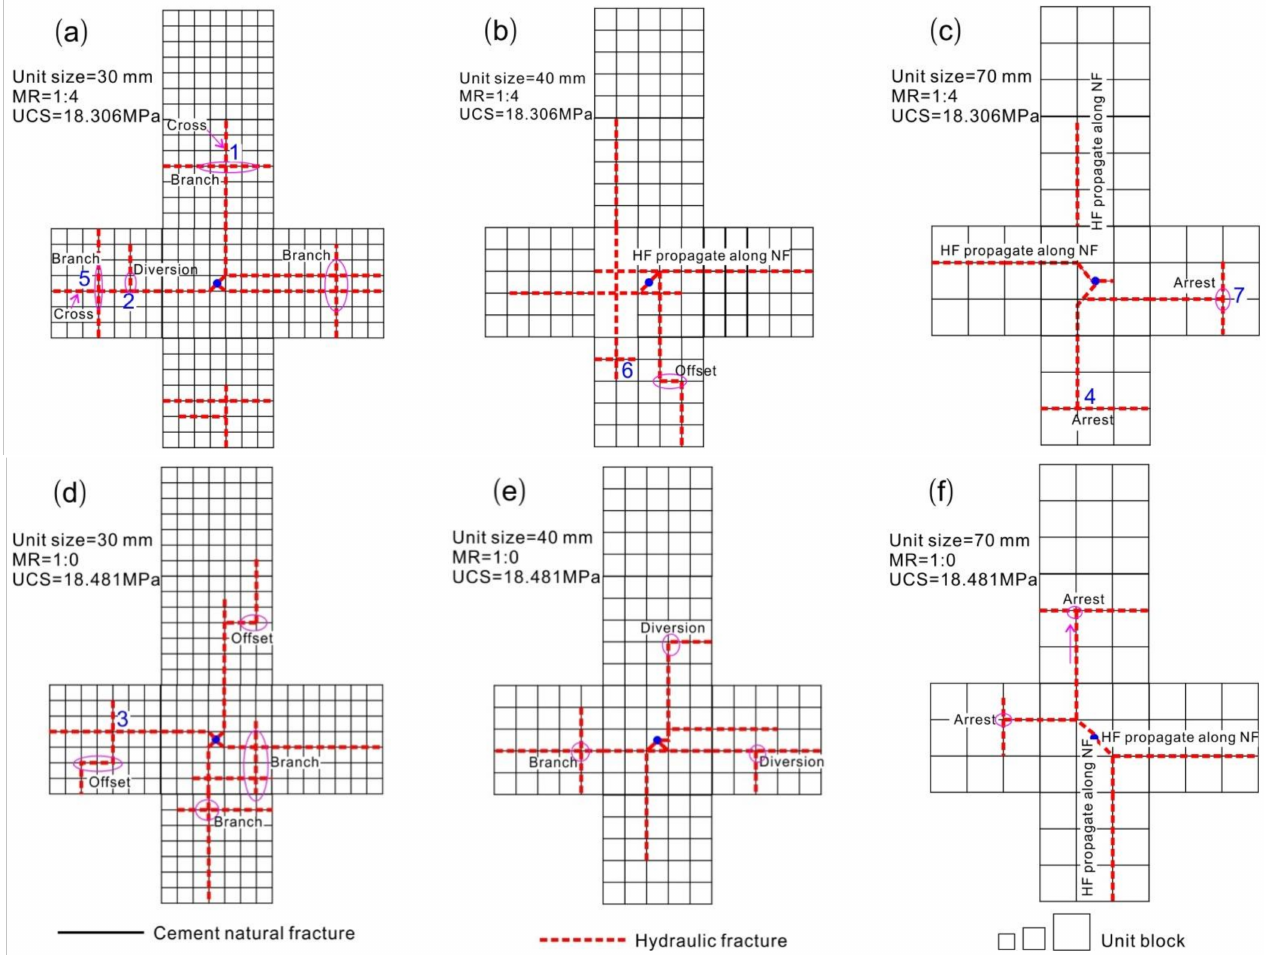
Figure 8. Sketch of the interaction between NFs and HFs. ( a – c ) Unit block size is 30, 40, and 70 mm, respectively; the mix ratio of paste cement fracture is 1:4. ( d – f ) Unit block size is 30, 40, and 70 mm, respectively; the mix ratio of paste cement fracture is